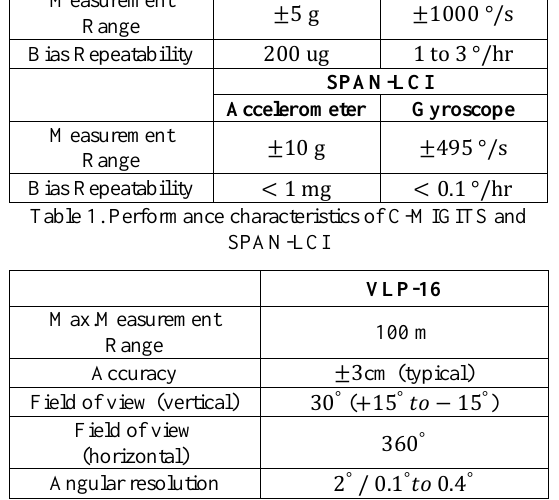
Table 2. Performance characteristics of Velodyne